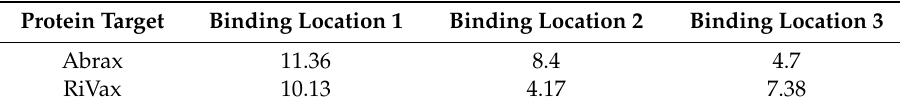
Table 4. Mean Local Hydrophobicity Density at Each Binding Location on Abrax or RiVax (Shown in Figure S5) Determined Using Fpocket.